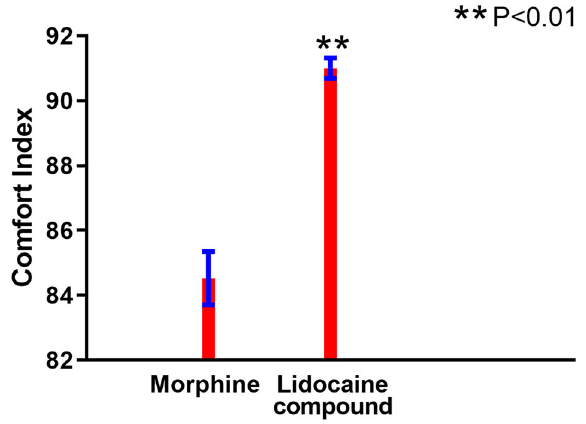
Figure 3. Comparison of comfort ratings between two groups of patients receiving systemic morphine or topical lidocaine com- pound for cancer wound dressing change. Data are reported as means ± SD. Student ’ s t -test was used for statistical analysis (P o